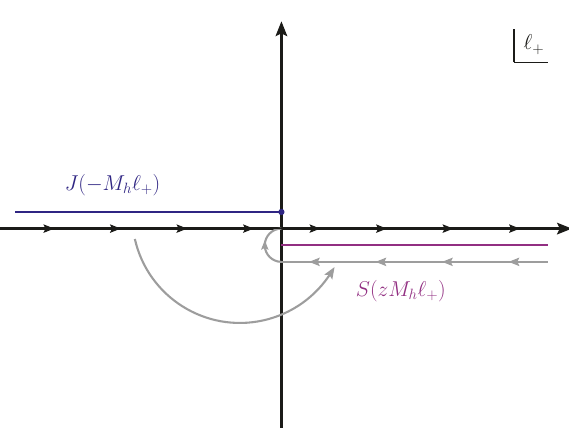
Figure 5 . Singularities of the integral (3.9) in the complex ‘ +